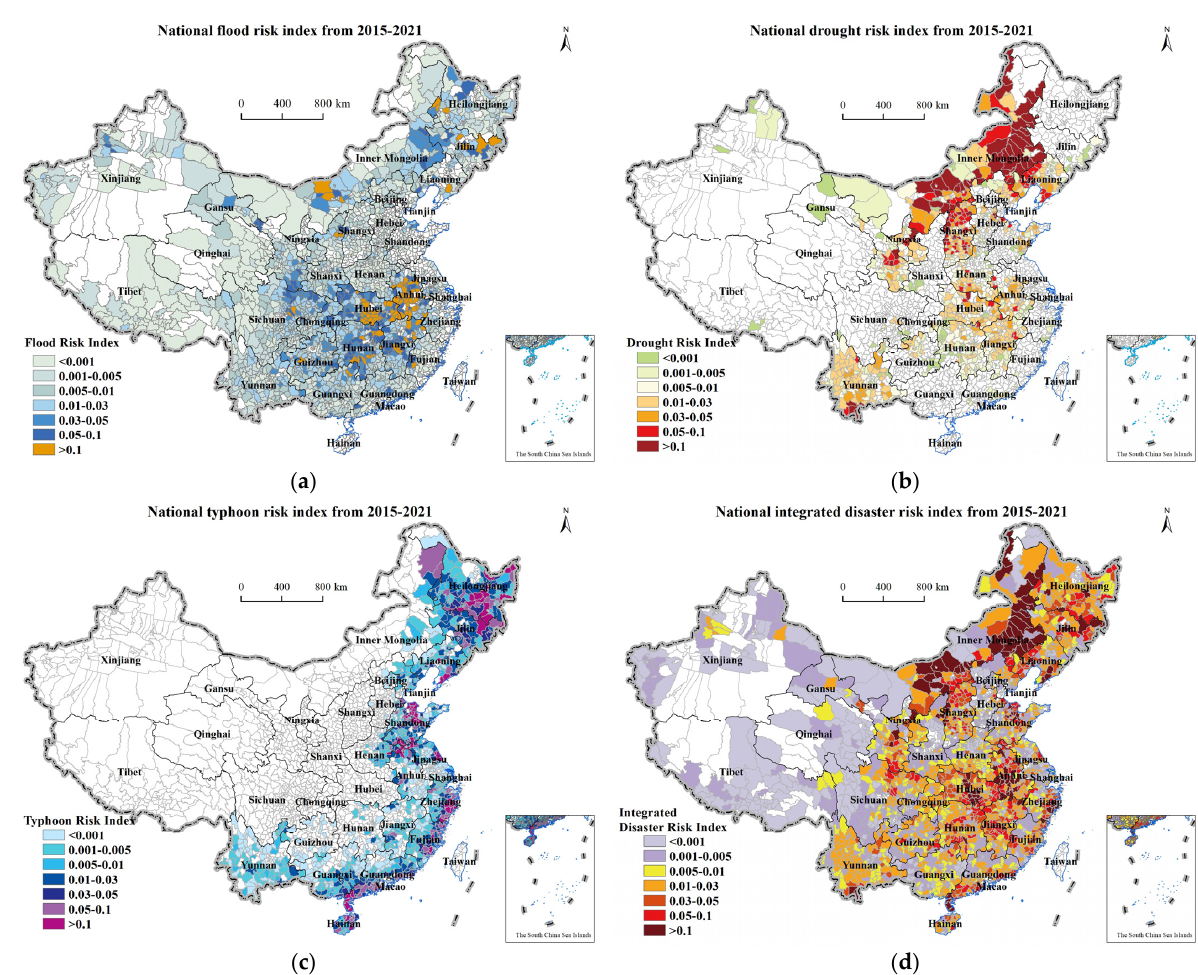
Figure 5. National flood( a ), drought( b ), typhoon( c ), and integrated disaster( d ) risk